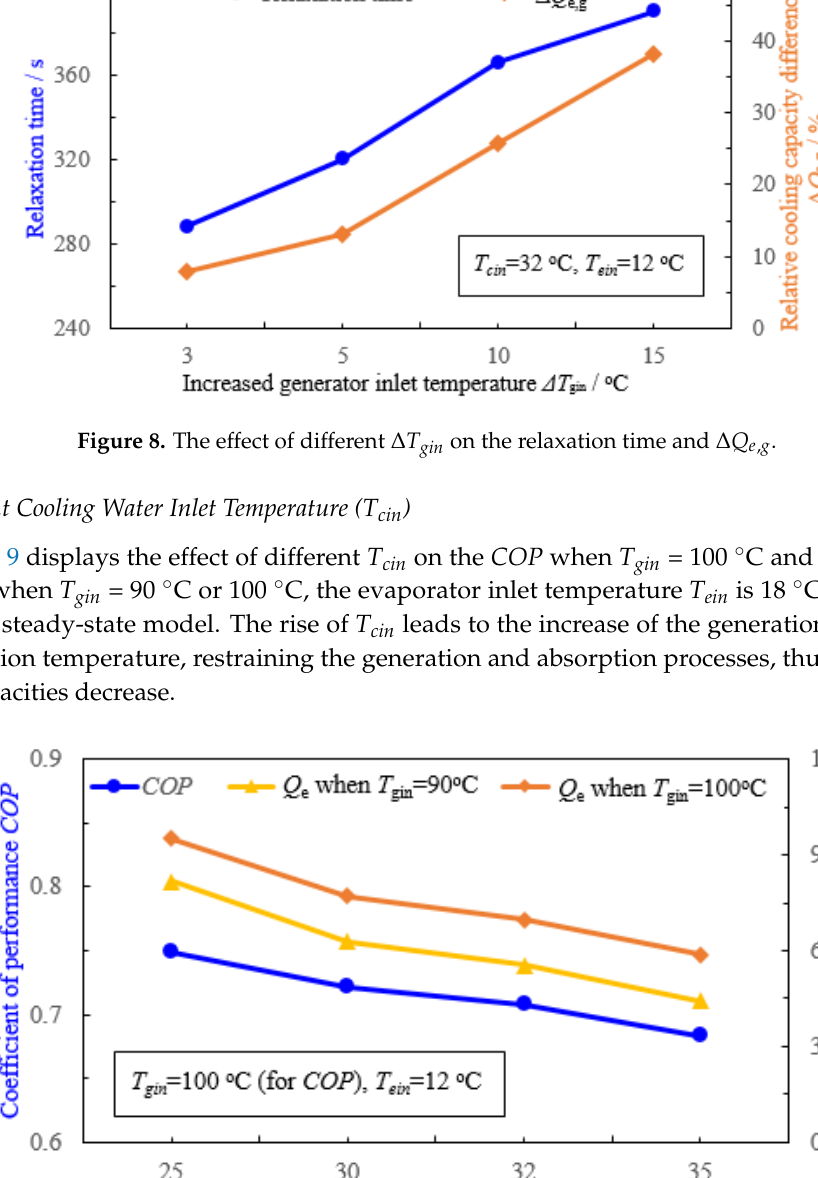
Figure 9. The effect of different T cin on the COP and cooling capacity.